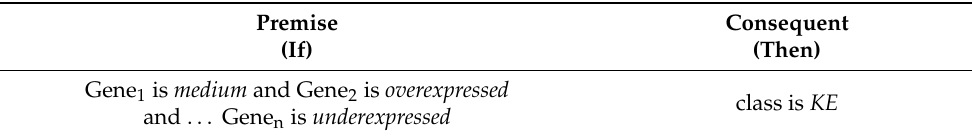
Consequent (Then) class is